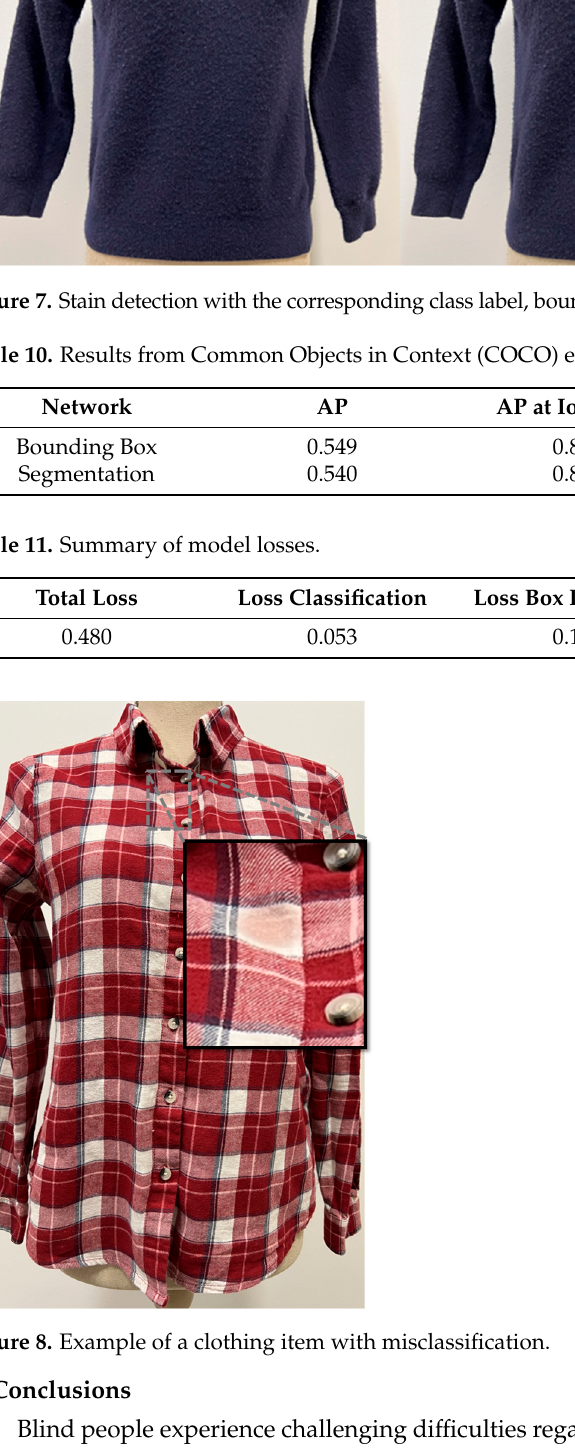
Table 10. Results from Common Objects in Context (COCO) evaluator.